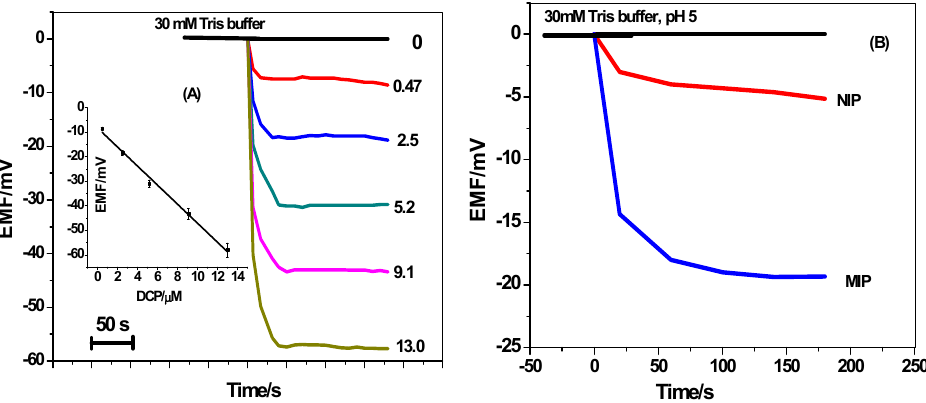
Figure 6. ( A ) The dynamic potentiometric responses of screen-printed platform towards neutral 2,4-DCP in 30 mm Tris buffer at pH 5. The inset shows the measuring calibration plot for 2,4-DCP; ( B ) The potential responses to 2.5 µm neutral 2,4-DCP using the blank, NIP and MIP based membranes.